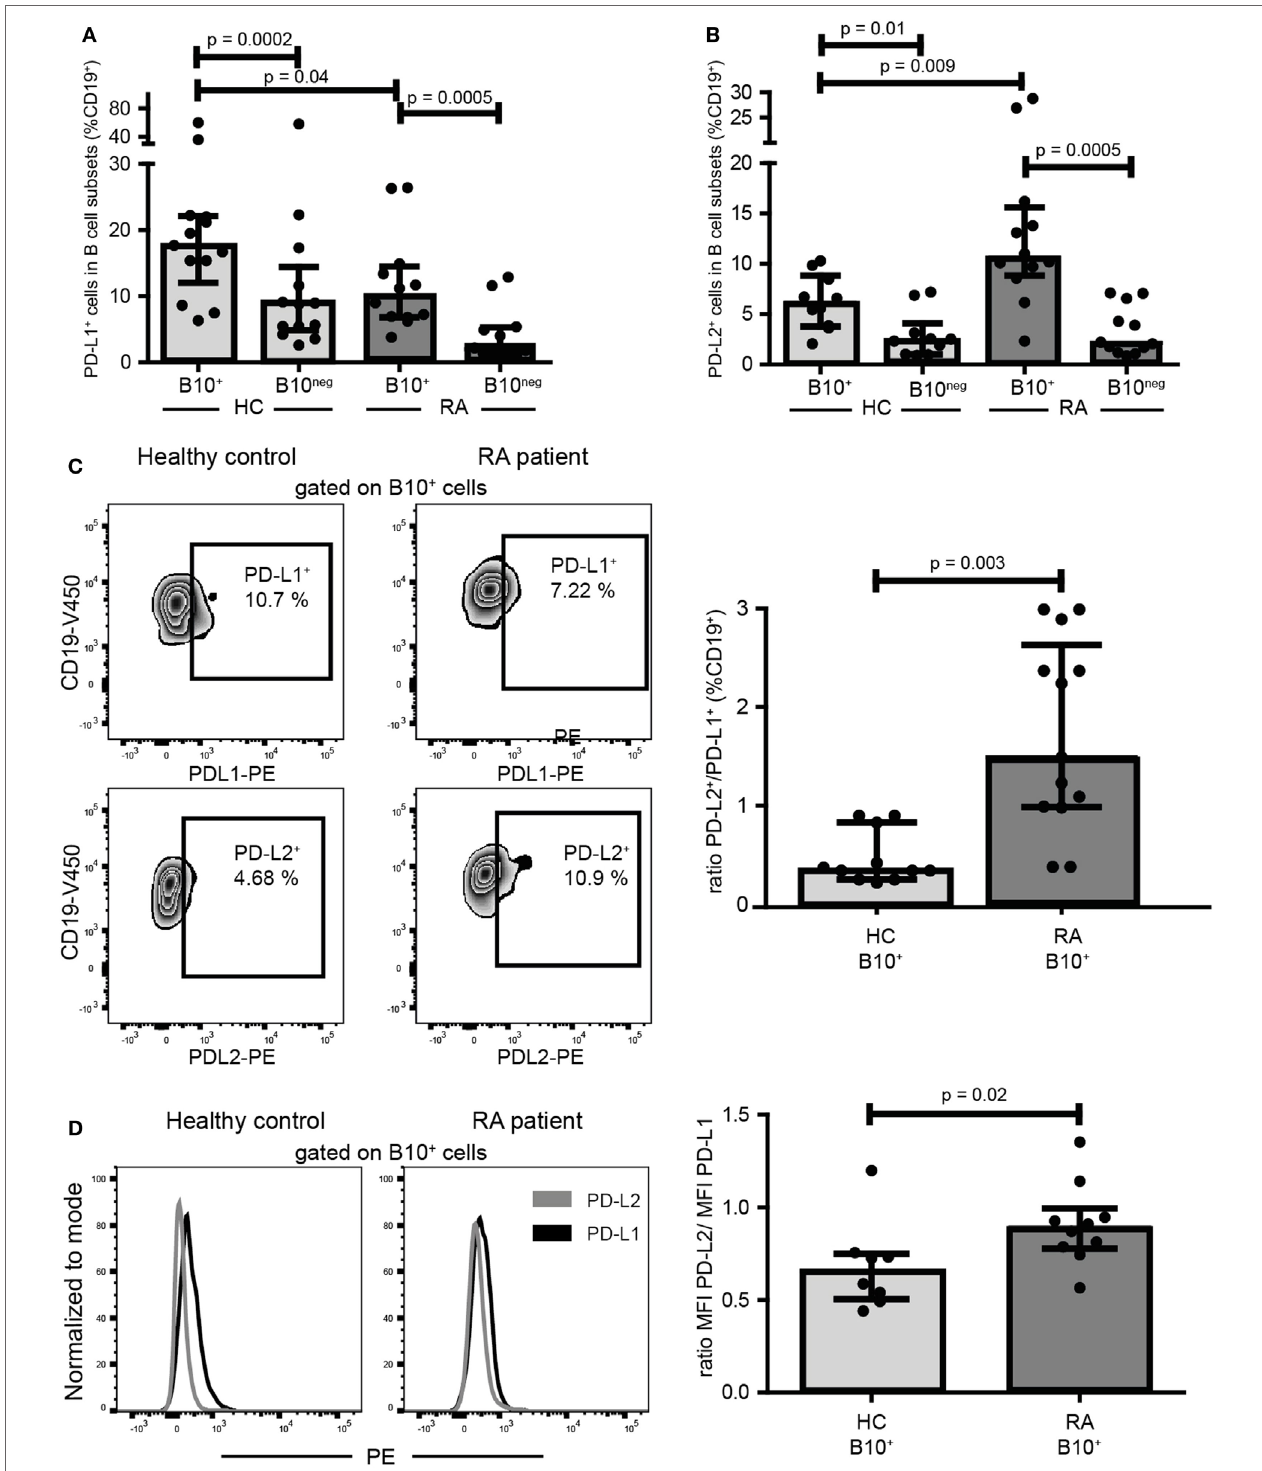
FigUre 6 | B10 + cells from rheumatoid arthritis (RA) patients expressed less PD-L1 and more PD-L2 than B10 + cells of healthy controls (HC). PBMCs were cultured for 24 h with CpG. Percentages of PD-L1 (a) and PD-L2 (B) positive cells among B10 + and B10 neg cells subsets were assessed in HC and in RA patients by flow cytometry. Representative flow cytometry plots and ratios of B10 + PD-L2 + /B10 + PD-L1 + cells are shown in (c) . (D) Representative overlays and median of fluorescence intensity (MFI) showing PD-L2 and PD-L1 expression levels on B10 + cells. Medians and interquartile ranges are represented in the graphs. p values were calculated with Wilcoxon matched test for paired data or Mann–Whitney test for comparison between RA and